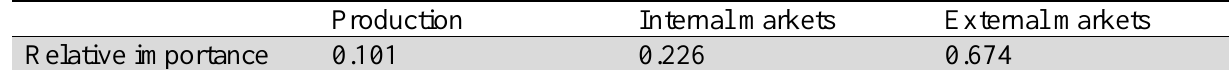
Relative importance of IHCI’s sub-processes calculated by AHP